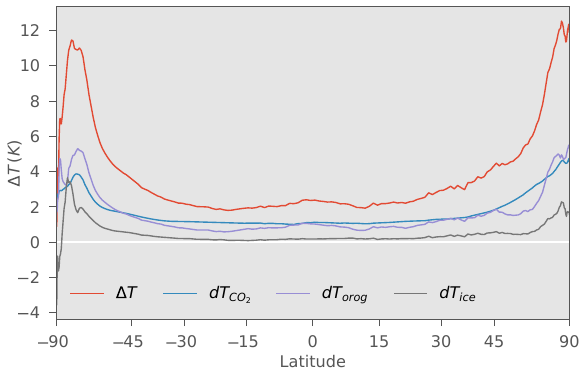
Figure 8. Zonal mean of the MASAT anomalies shown in Fig. 7. The abscissa is linear in the sine of